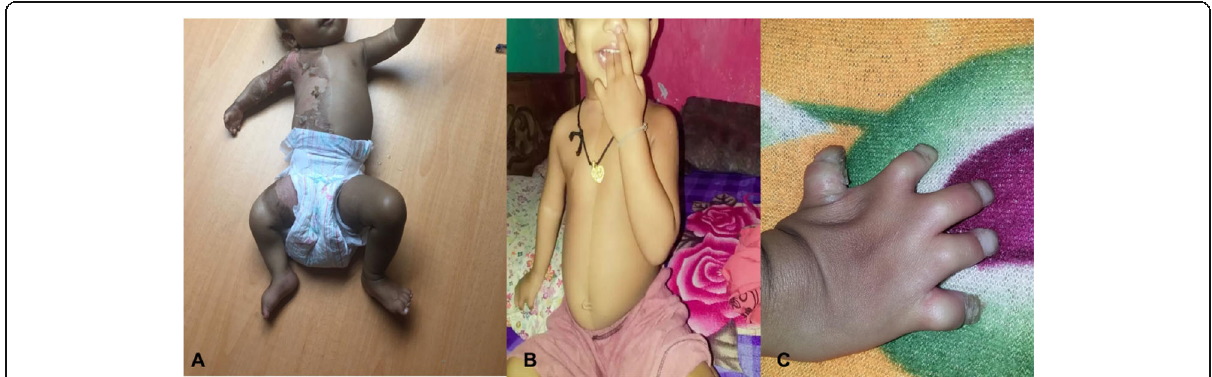
Fig. 1 a – Proband at 9 months with ipsilateral ichthyosiform erythroderma and Hypoplasia of arm and hand. b - Proband after 1 year, following treatment. Images showing remarkable improvement in the skin lesions. c - Simple syndactyly of right hand with nail